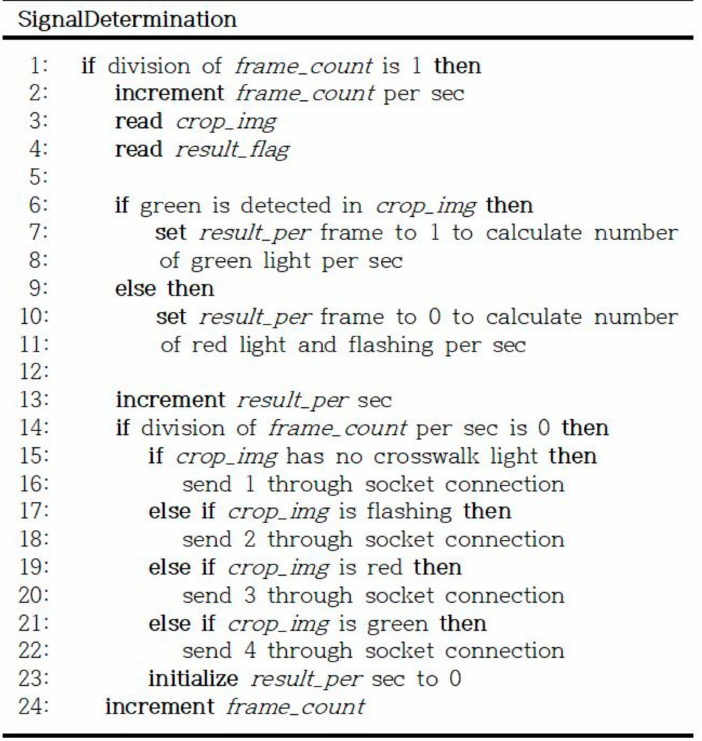
Figure 3. Algorithm for crosswalk safety